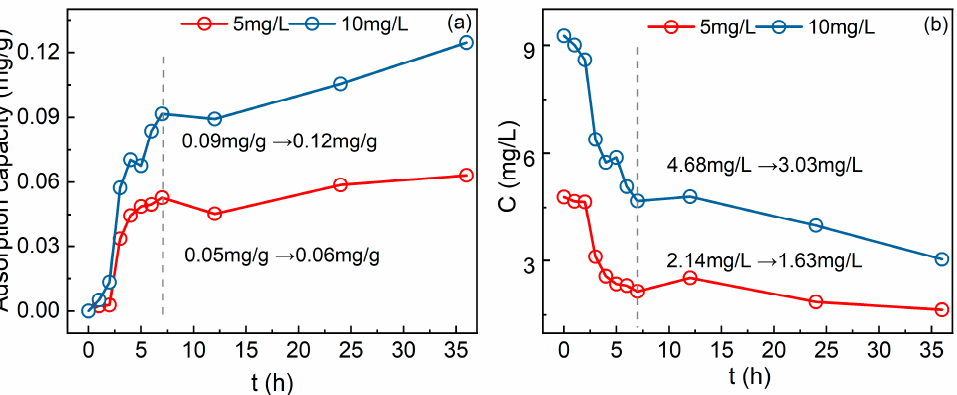
Figure 2. Batch adsorption experiments of P with extended time: ( a ) changes of equilibrium adsorp- tion capacity and ( b ) shift of P concentration in supernatant.